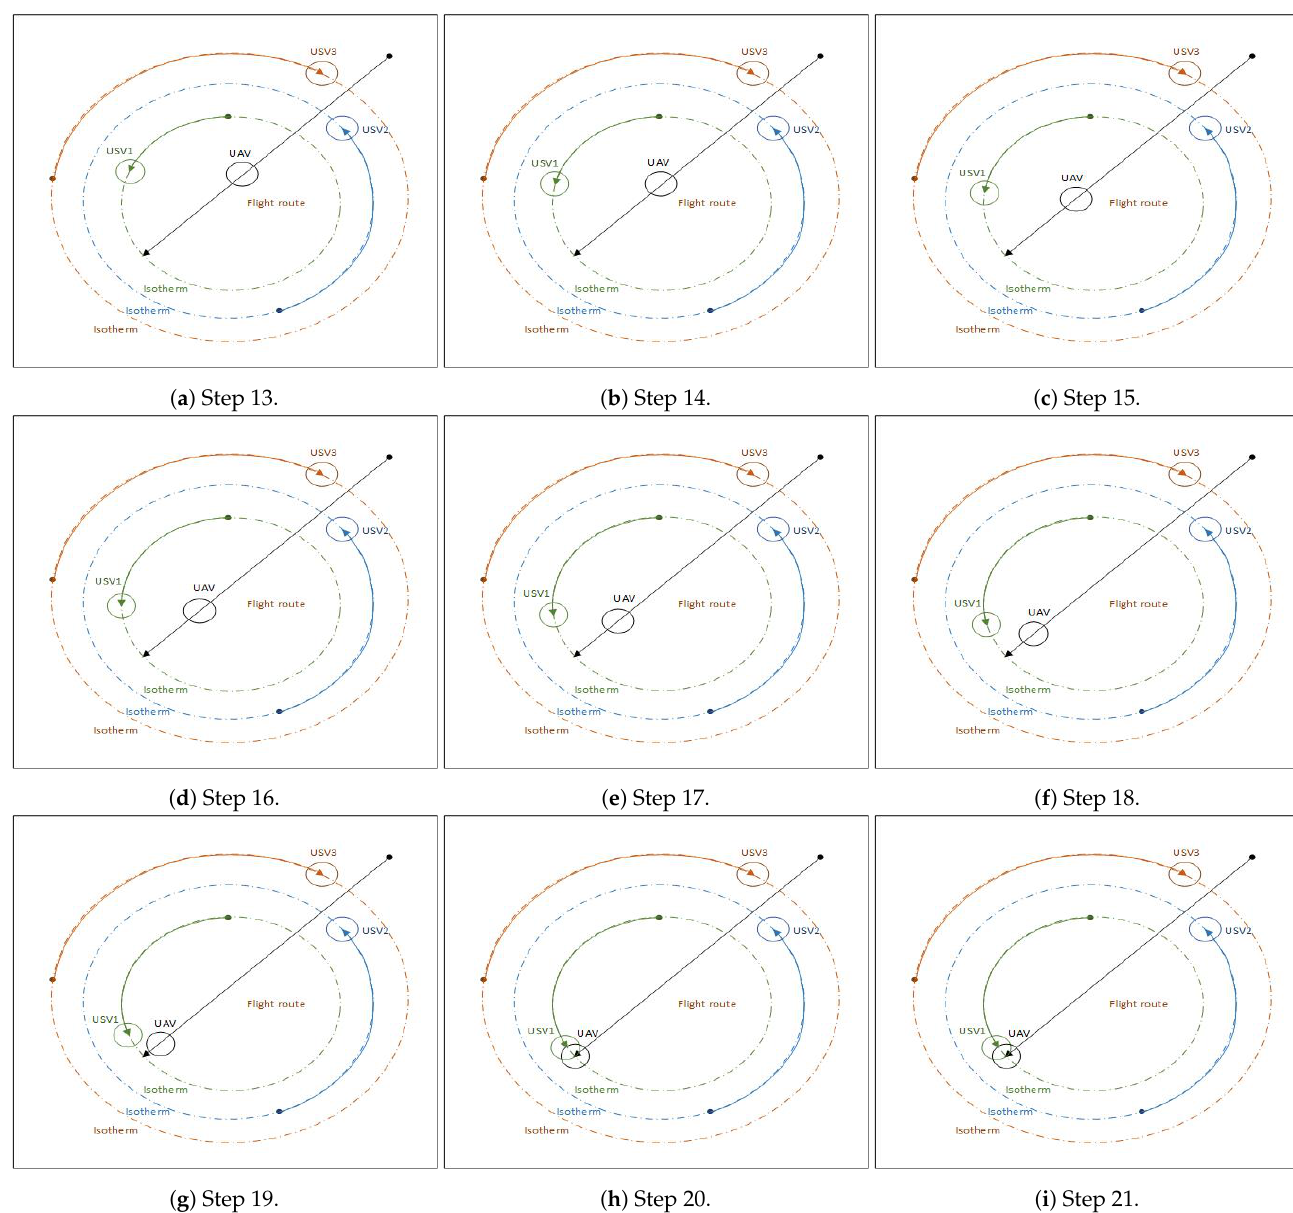
Figure A2. Experiment of cooperative control algorithm process without noise (Step 13–Step